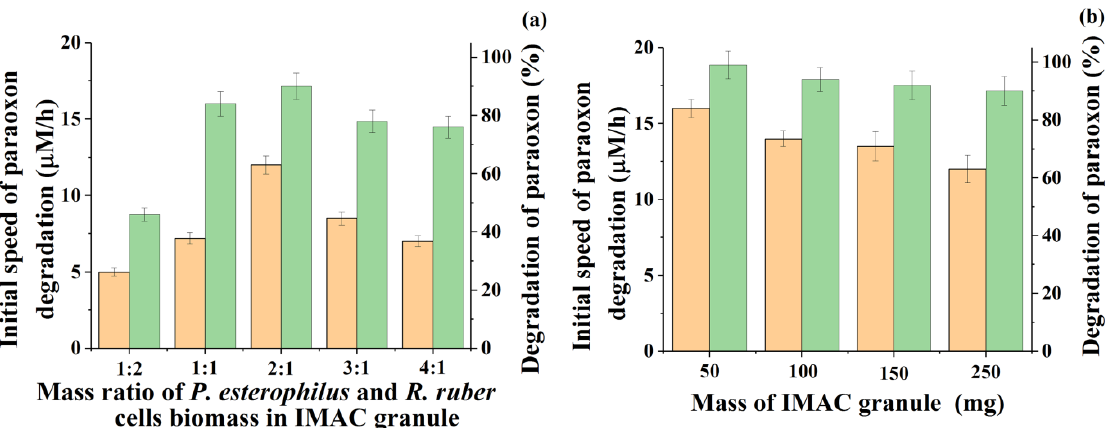
Figure 1. Influence of the ratio between Pseudomonas and Rhodococcus cell biomass in the content of IMAC ( a ) and the mass of each granule ( b ) with 10% ( w / w ) of total cell concentration on the initial speed of paraoxon (0.15 mM) degradation ( ◼ ) and the degradation degree of the pesticide ( ◼ ) catalyzed by the IMAC.